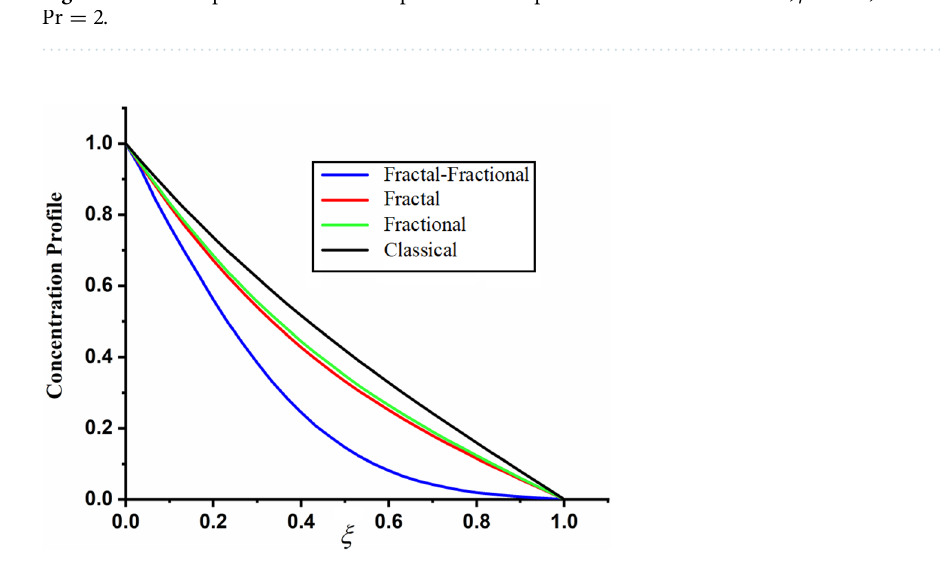
Figure 16. The comparison between fractal-fractional, fractal, fractional and classical concentration when α = 0.5 , β = 0.5 , t = 0.2 , Sc = 0.5 and Re = 3